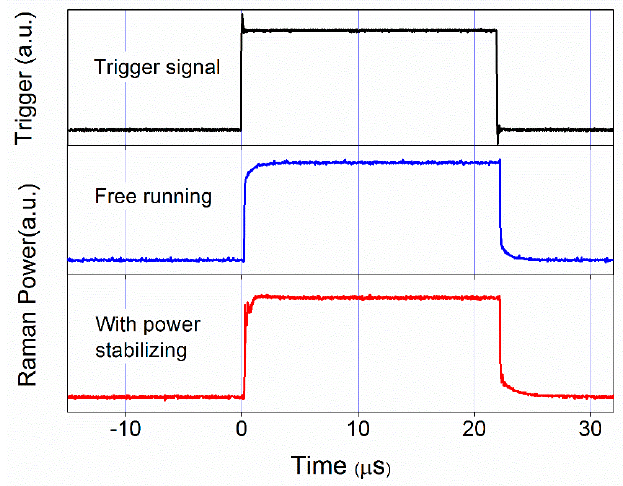
Figure 9. On-off time comparison of trigger signal and Raman lasers pulse (in free running and with power stabilizing).